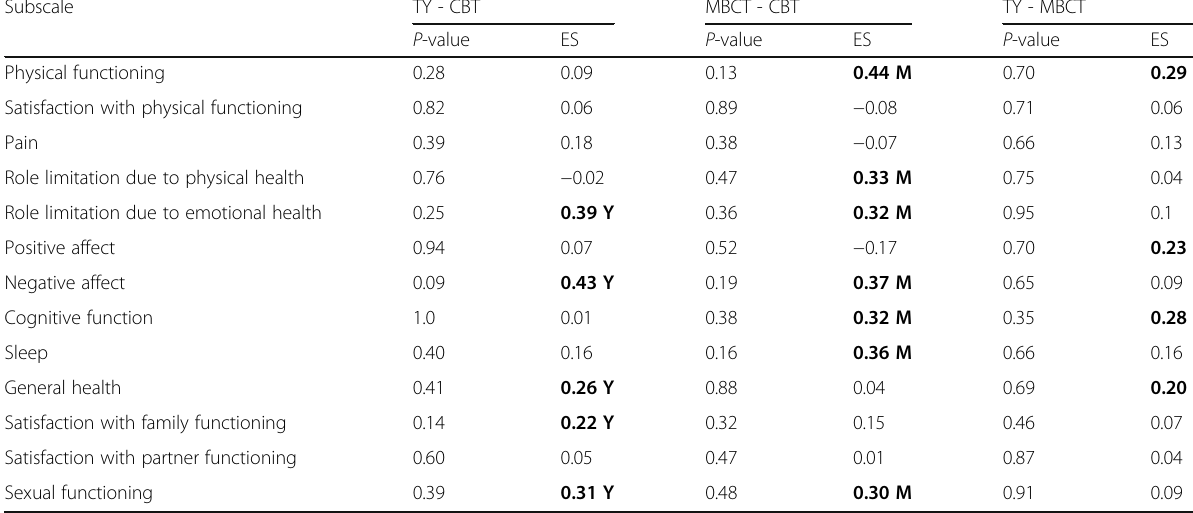
Table 7 Comparison between the groups ’ treatment effects, measured by SWED-QUAL subscale scores, as p -values a and effect size b Subscale TY - CBT MBCT - CBT TY - MBCT P -value ES P -value ES P -value